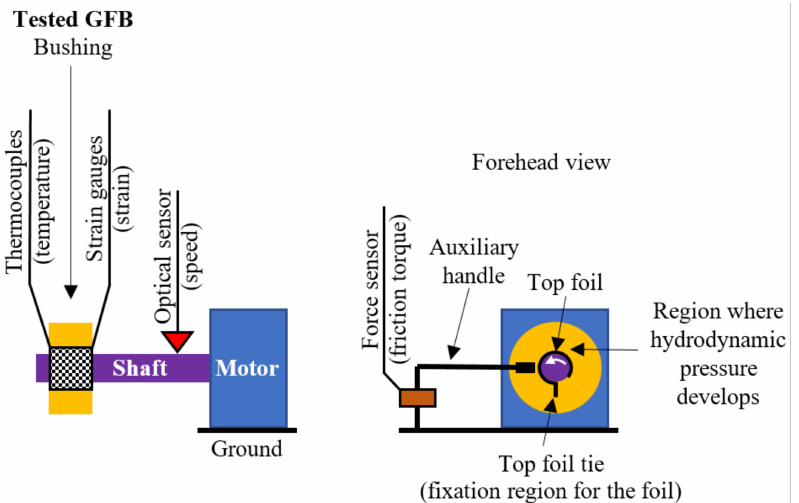
Figure 7. Schematic view of the freely-suspended configuration used for thermal and mechanical characterization of the tested GFB. The specialized sensing top foil—marked with the chessboard pattern—was mounted in the tested GFB and enabled temperature and strain measurements. The white arrow drawn on the shaft indicates its direction of